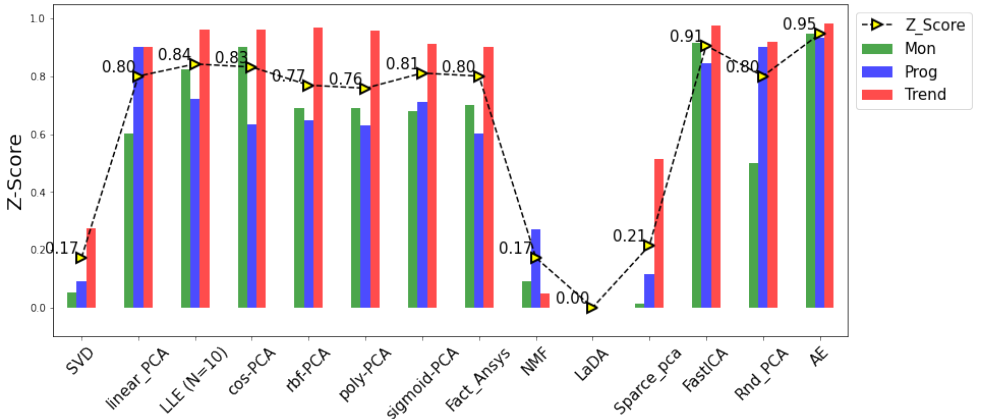
Figure 6. Comparison between prognostics capability of fusion